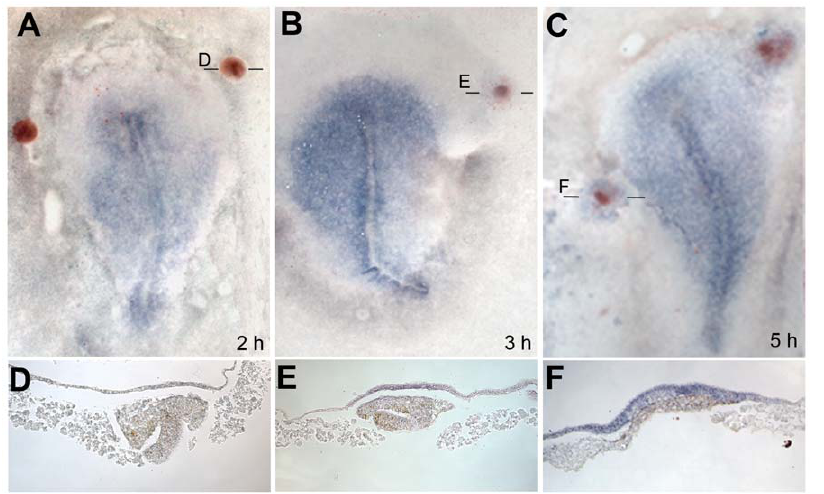
Figure 8. Time-course of induction of Obelix by Hensen’s node. Time-course of induction by grafts of a quail node into a chick host. No induction is seen at 2 hours (A), weak induction starts at 3 hours (B) and robust induction is seen by 5 hours (C). D–F are sections through the grafted regions of the embryos in A–C at the levels indicated. Quail donor cells are stained brick-red by QCPN antibody and Obelix mRNA in purple/blue.